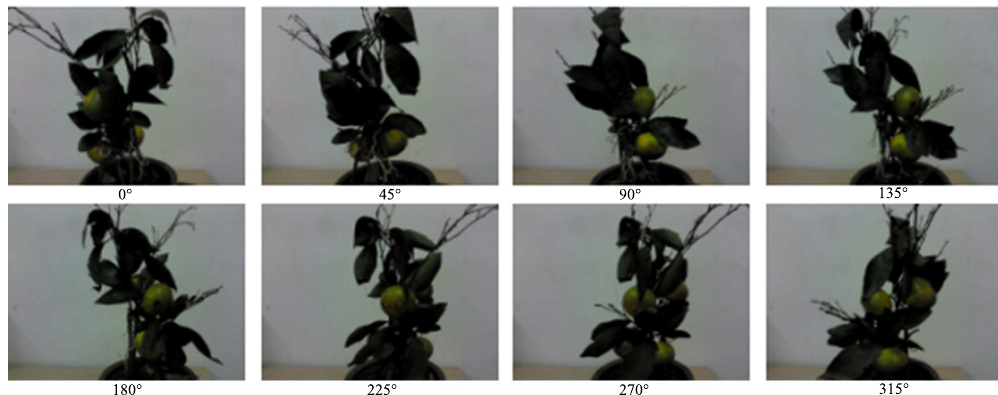
Figure 15. A set of complex fruits and leaves experiment position-postures on a branch.